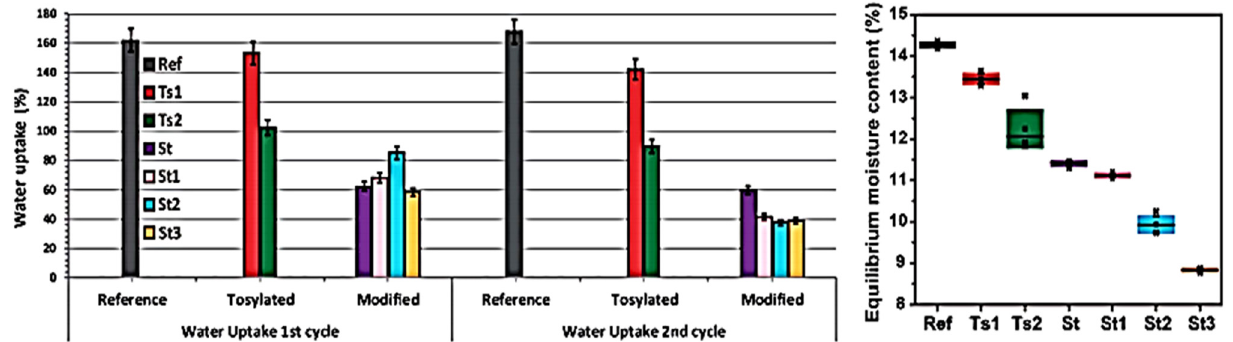
Figure 12: Left: water uptake values for unmodi fi ed wood ( Ref ) , tosylated wood ( Ts1, Ts2 ) , and modi fi ed wood ( St, St1, St2, and St3 ) . Right: equilibrium moisture content ( EMC ) values of reference, tosylated, and modi fi ed samples [ 107 ]